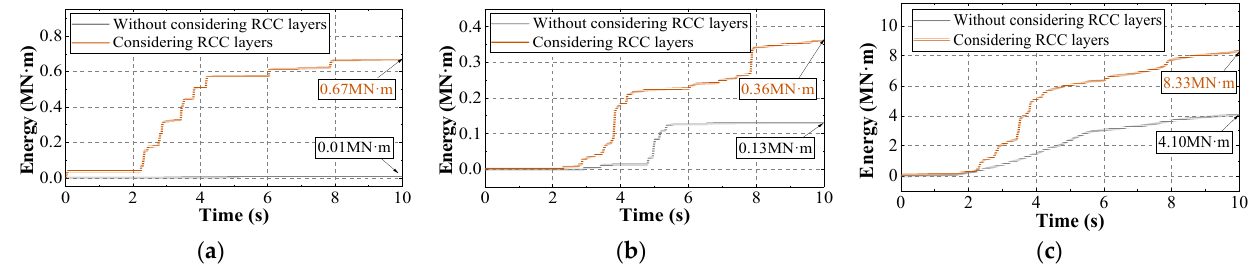
Figure 25. Comparison of the energy dissipation. ( a ) Damage energy dissipation; ( b ) plastic energy dissipation; ( c ) viscous energy dissipation.